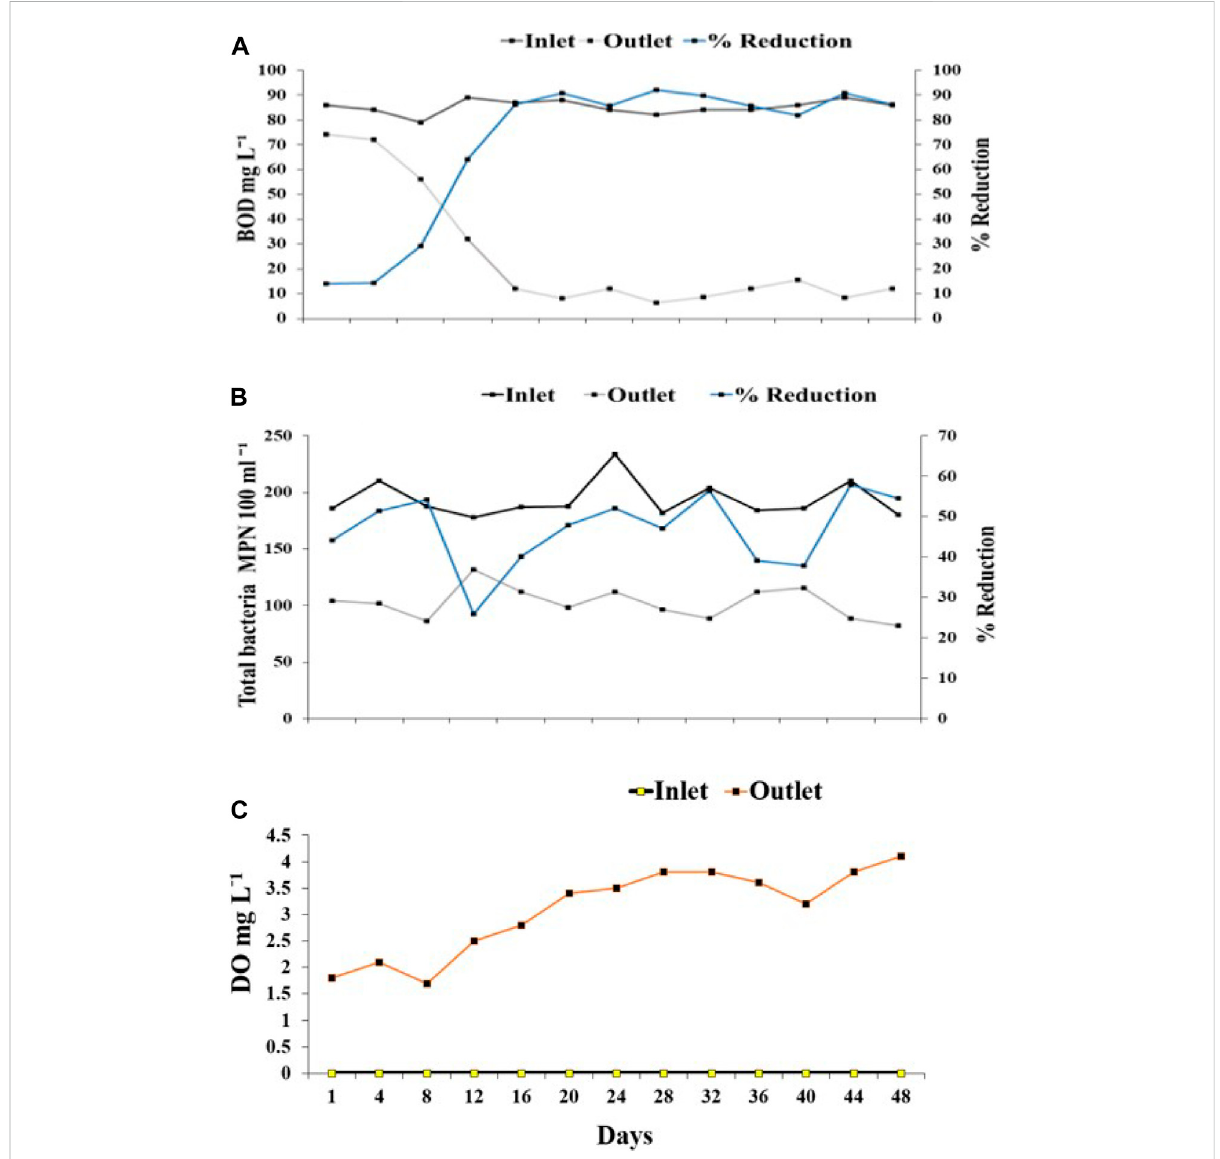
FIGURE 10 Puri fi cation potential of CWS (A) Biological Oxygen Demand (BOD) concentration in the inlet and outlet site, and percentage reduction in BOD at outlet of CWS, (B) Total bacterial count in the inlet and outlet site of the CWS and percentage reduction in bacterial density at outlet of CWS; and (C) Dissolve Oxygen concentration in the inlet and